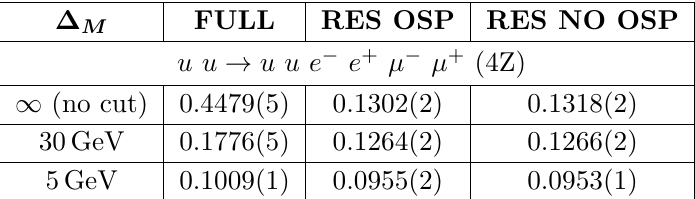
u u e (cid:0) e + (cid:22) (cid:0) (cid:22) + , for M M Z < (cid:1) M ( ‘ = e; (cid:22) ). ‘ + ‘ (cid:0) (cid:0) ! j j > 20 GeV ; (cid:17) j < 5 : 5 ; M jj > 600 GeV ; (cid:1) (cid:17) jj > 3 : 6 ; M 4 ‘ > t j j j j